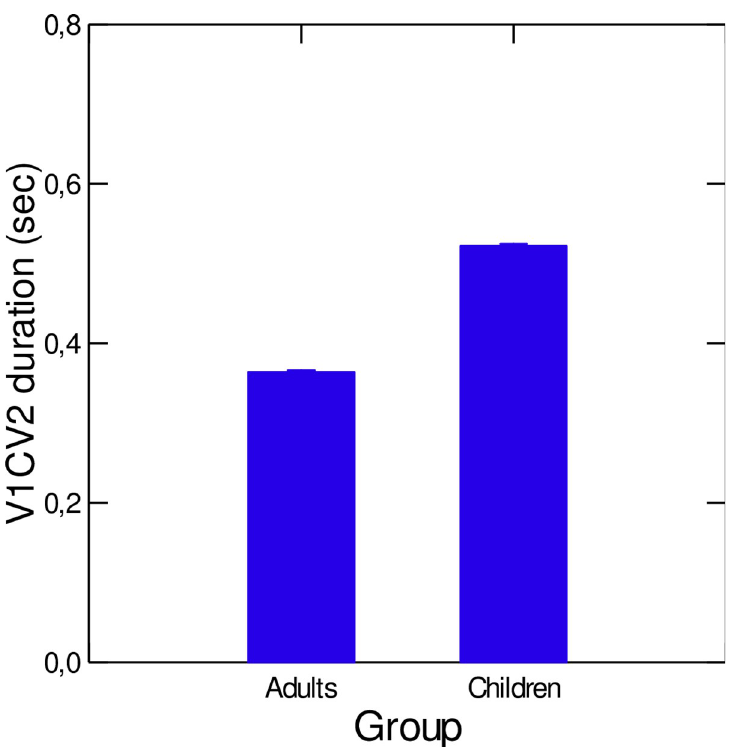
Fig 6. Average duration of V 1 CV 2 sequences, for both speaker groups. Error bars are standard errors of the mean.